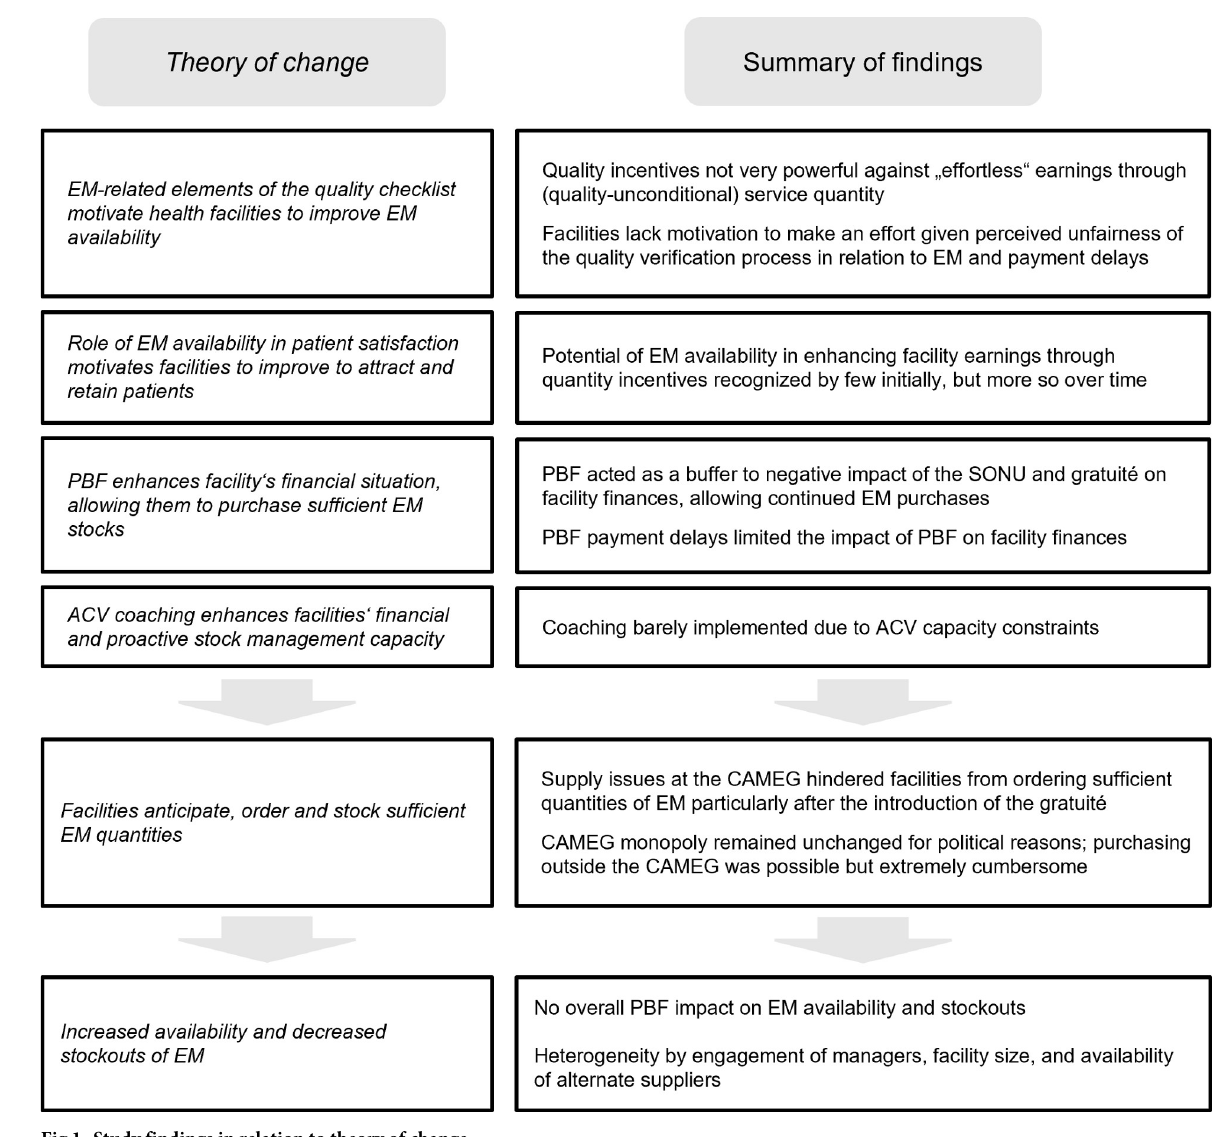
Fig 1. Study findings in relation to theory of